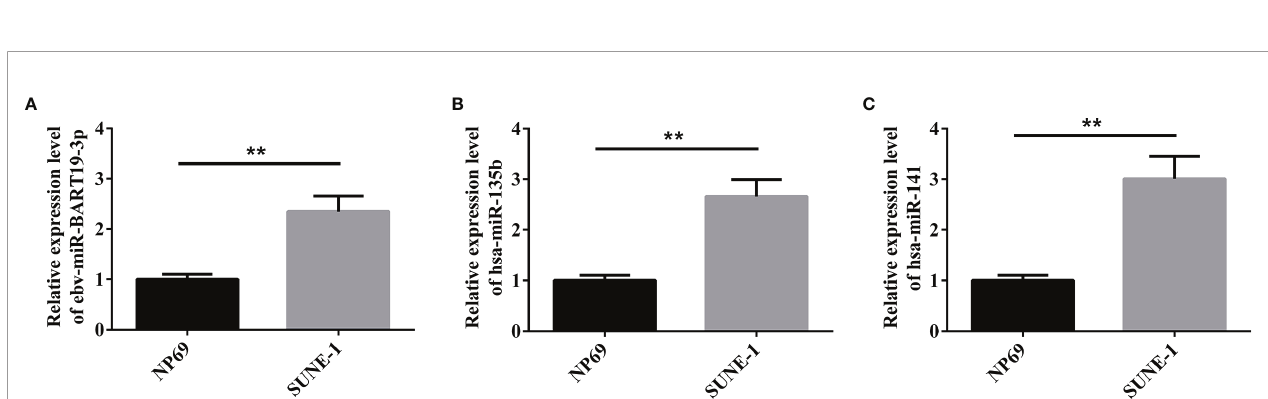
FIGURE 5 | qPCR to verify the expression of the three miRNAs. (A) expression level of ebv-miR-BART19-3p; (B) expression level of hsa-miR-135b; (C) expression level of hsa-miR-141; **P <